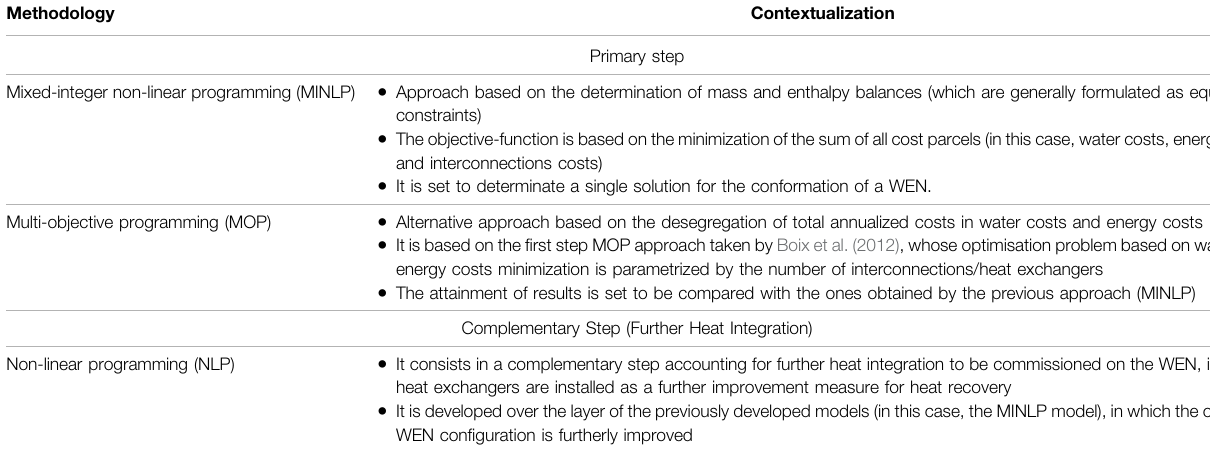
TABLE 5 | Contextualization of optimisation